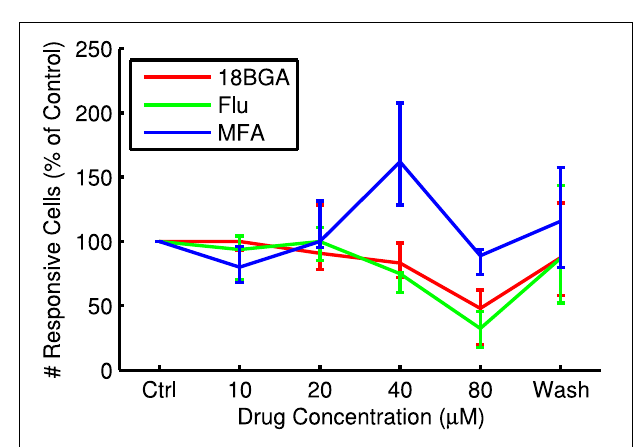
FIGURE 2 | (A) Spontaneous firing rate as a percentage of control conditions for each concentration of all three drugs, averaged over all channels with recorded spikes and all retinas. (B) Oscillation strength as a